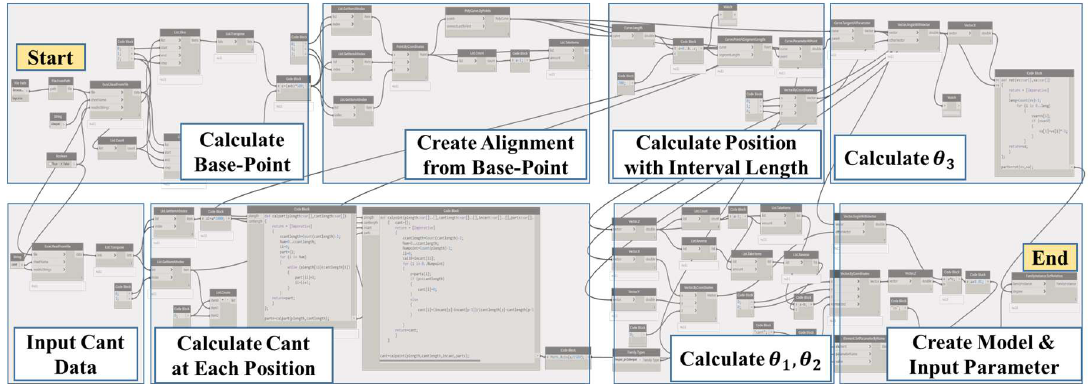
Figure 9. Algorithm for shape representation of discontinuous objects in Autodesk Dynamo Studio.